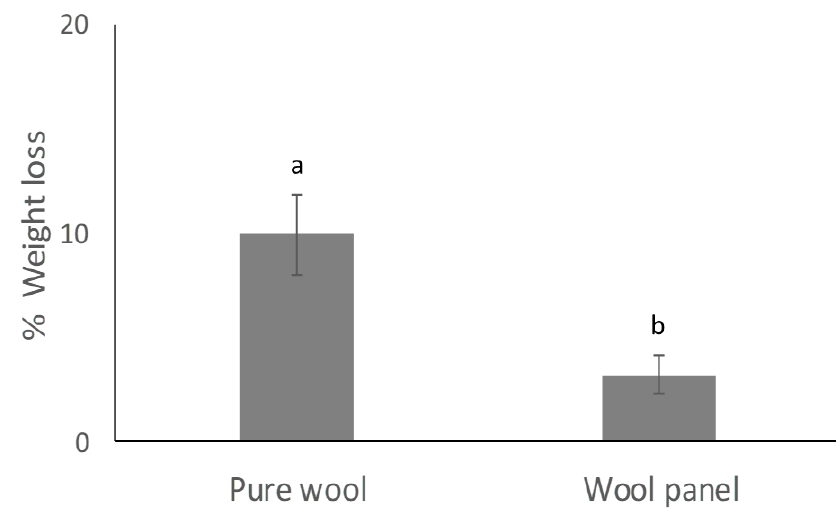
Figure 2. Weight loss of wool panel compared with pure wool samples exposed to clothes moth larvae for 15 days. Different letters above bars indicate significantly different means ( t ‐ test, p < 0.001). Larvae exposed to the commercial wool panel during the bioassay appeared to be less vital and their over ‐ time mortality was significantly higher (F 1,6 = 52.61, p = 0.0003), compared with larvae maintained on pure untreated wool (Figure 3). A significant mortality effect of exposure time was also detected (F 14,84 = 44.41, p < 0.0001).